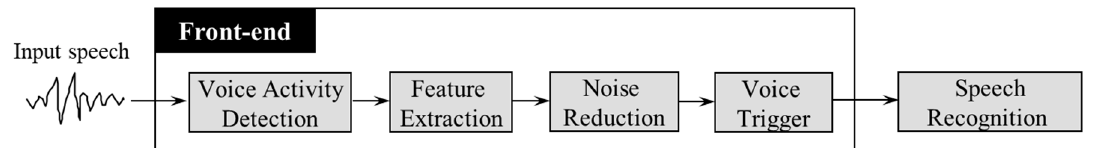
Figure 4. General procedure of speech recognition front-end.